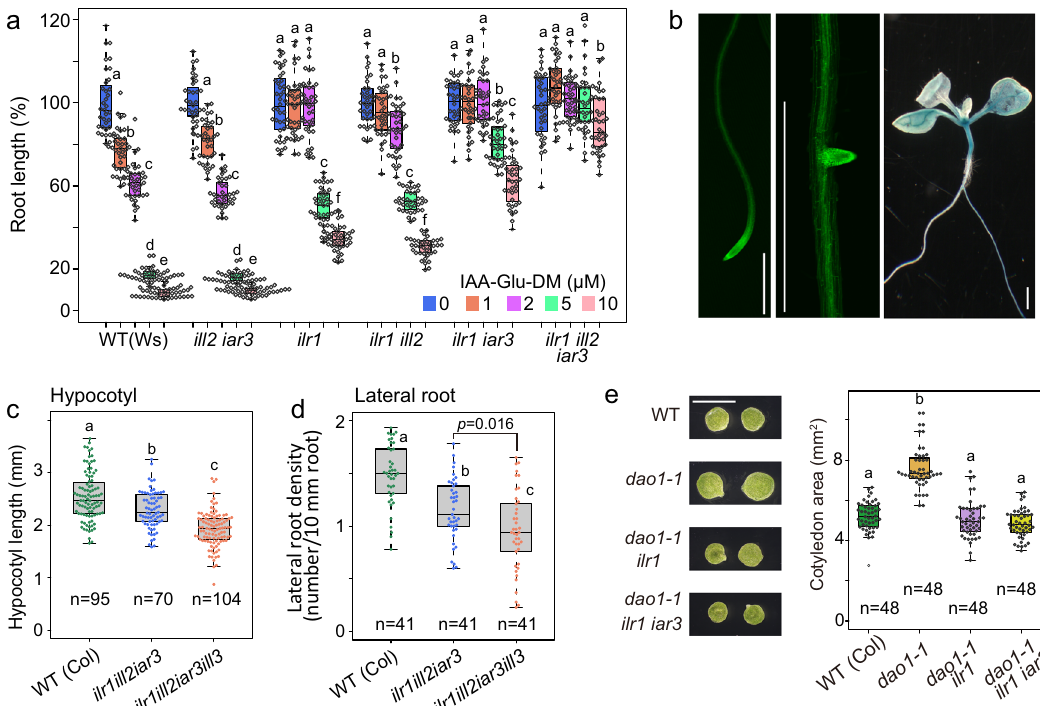
Fig. 5 ILR1/ILL enzymes are involved in IAA release from IAA-Asp and IAA-Glu in Arabidopsis . a Sensitivity of ilr1/ill mutants (Ws background) to IAA- Glu-DM. Root length (6-d-old) is shown as the percentage of that in mock-treated plants (100%). The different letters represent statistical signi fi cance at P < 0.001 (Tukey ’ s HSD test, n = 34 ‒ 42). b Expression patterns of ILR1-GFP and ILR1-GUS fusion proteins under the ILR1 promoter. At least fi ve plants from each line were examined. Scale bars, 1 mm. c , d Hypocotyl length and lateral root number of 8-d-old ilr1 ill2 iar3 ill3 quadruple mutants. The different letters represent statistical signi fi cance at P < 0.001 (Tukey ’ s HSD test, b – c in Fig. 5d: P = 0.016). e Cotyledon area of dao1-1, dao1-1 ilr1 , and dao1-1 ilr1 iar3 mutants. The plants were grown on vertical GM plates for 8 days. Scale bar, 5 mm. The different letters represent statistical signi fi cance at P < 0.001 (Tukey ’ s HSD